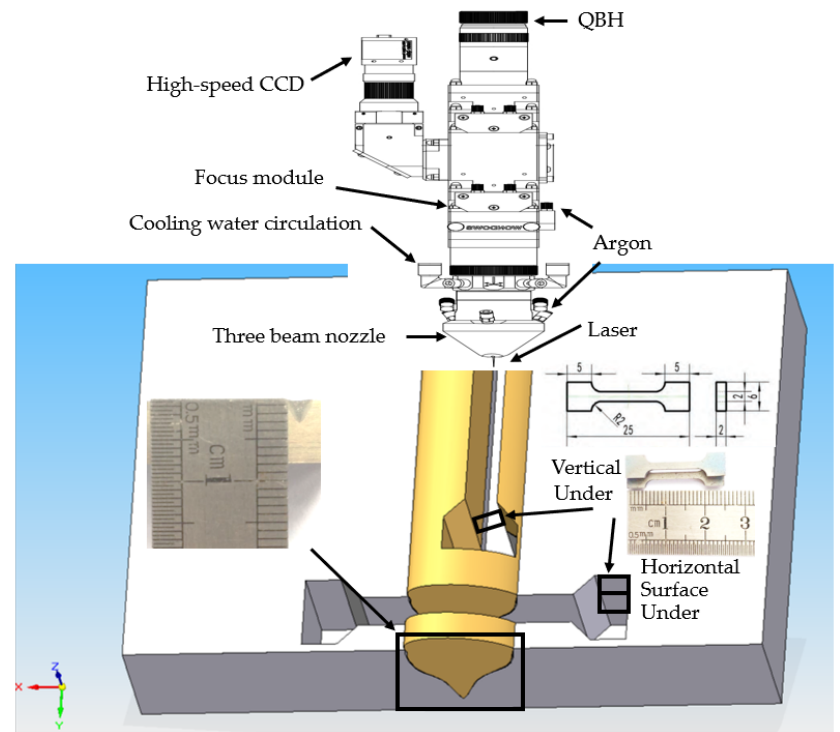
Figure 2. Test sampling